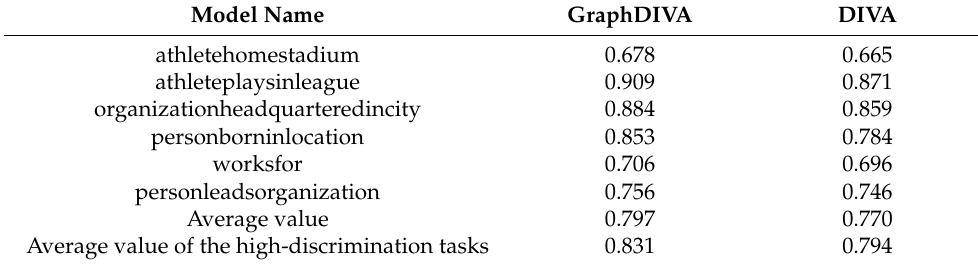
Table 5. NELL-995 test